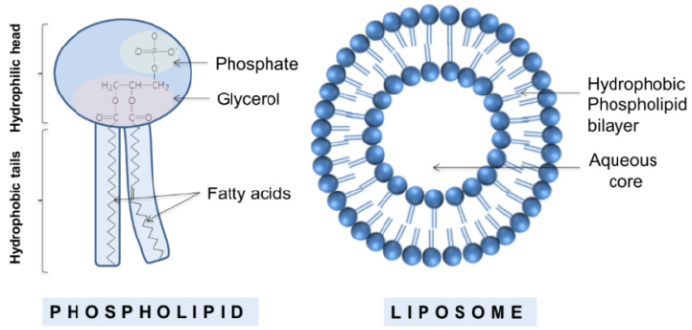
Figure 1. Schematic representation of a liposome.